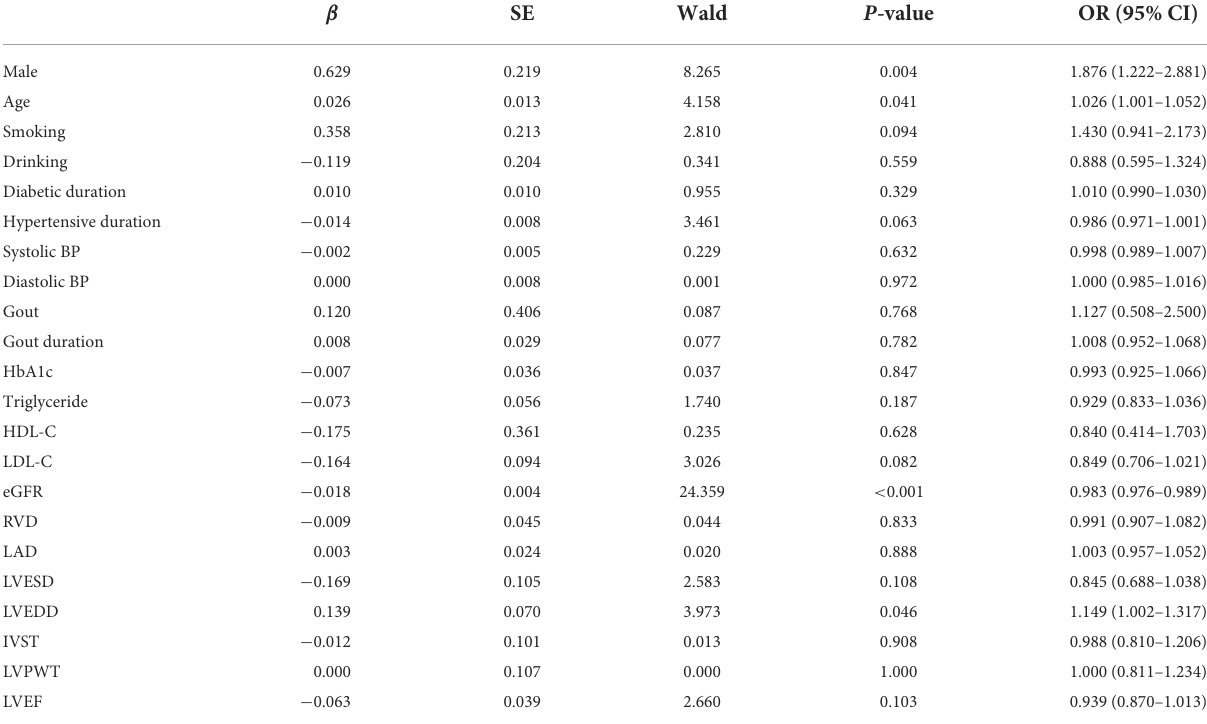
TABLE 3 Regression analysis of parameters associated with NLR ≥